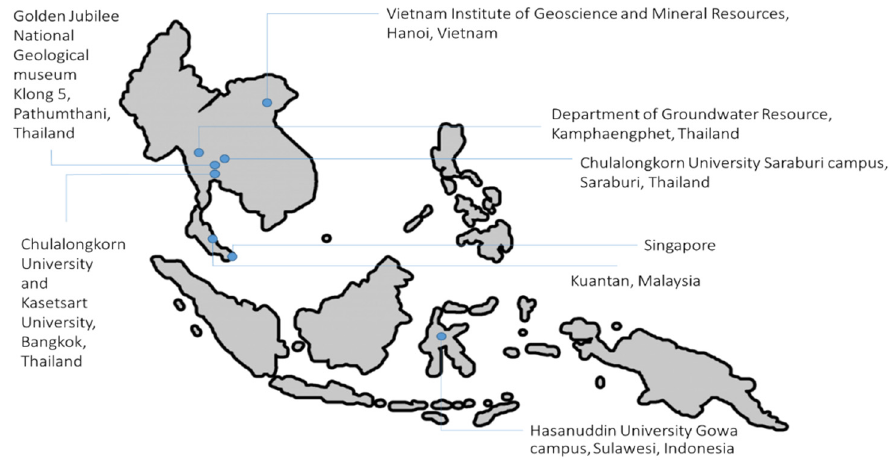
Figure 1. Locations of GSHP experiments within the Southeast Asia countries in a tropical climate.